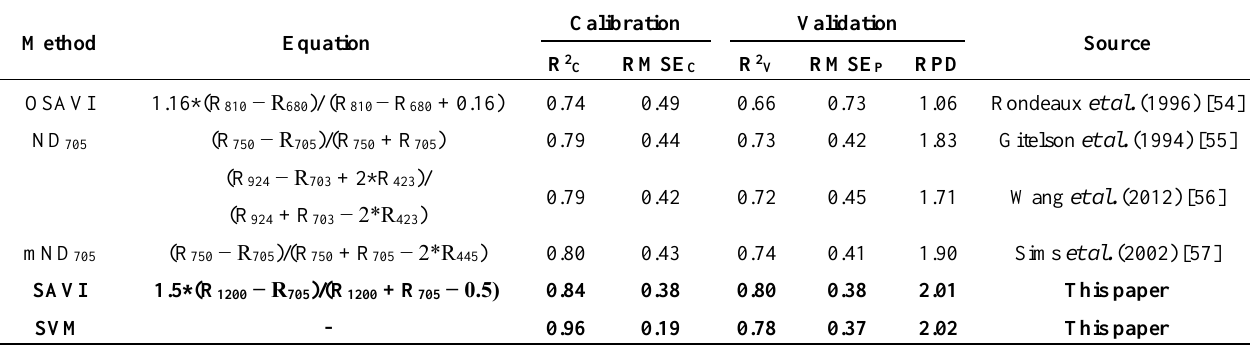
Table 11. Comparison of the SAVI(R 1200 , R 705 ) and SVM approaches with previous models for LNC